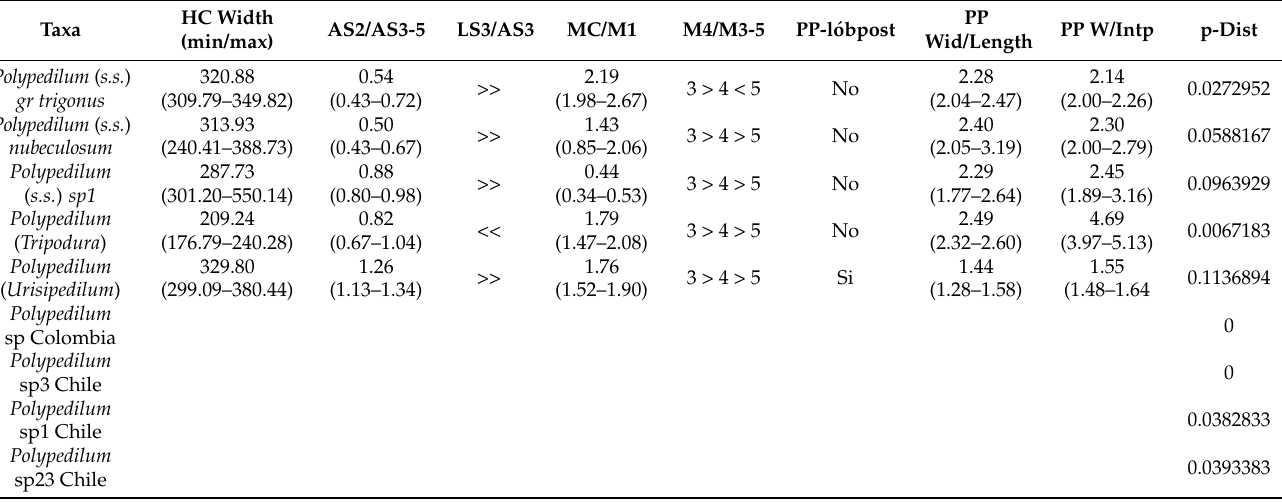
Table 2. El Oro’s Polypedilum morphotypes measurements, mean (min-max). HC: Head capsule; AS: Antennal segment; MC: Mentum central teeth length; M1: Mentum first teeth length; PP: Para- labial plates. p-dist: Pairwise distance.